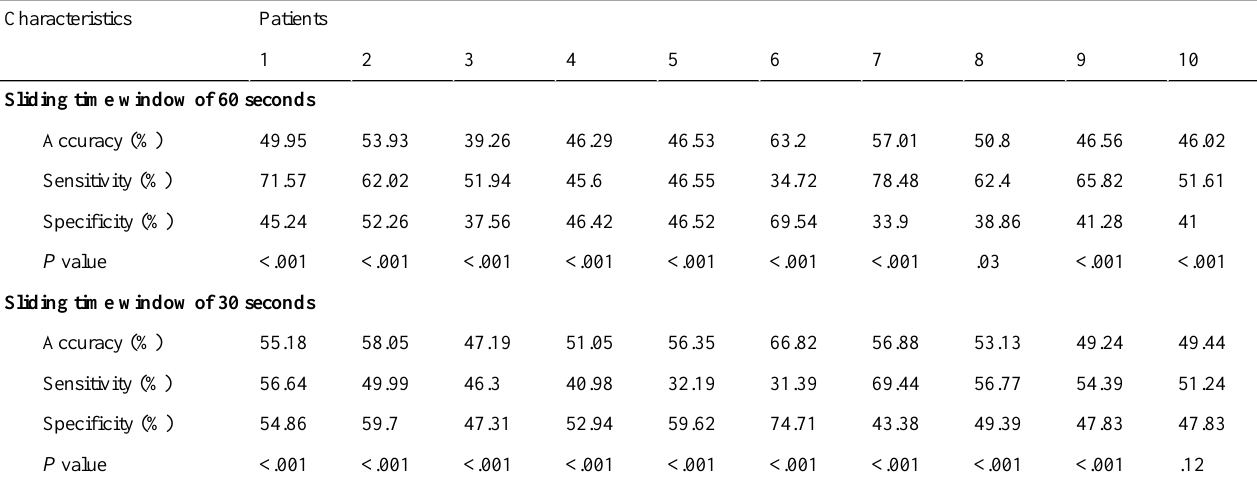
Table 6. Accuracy, sensitivity, specificity, and P value of apneic event detection; the two-tailed test was used to determine the P value.